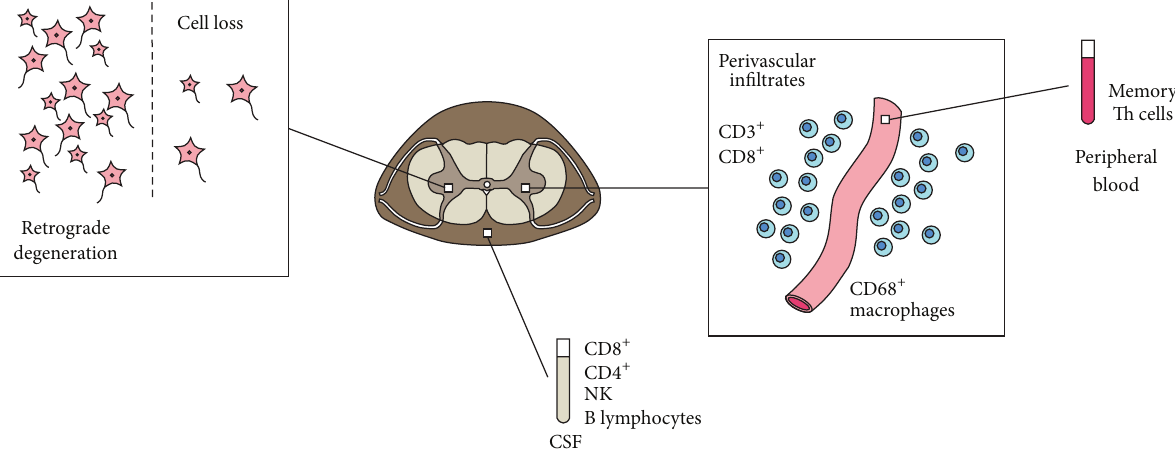
Figure 1: Lymphocytes of various subpopulations are found in affected regions of the nervous system, cerebrospinal fluid, and blood. The regions of the infiltrates do not always coincide with the area of cell loss that presumably comes from the retrograde